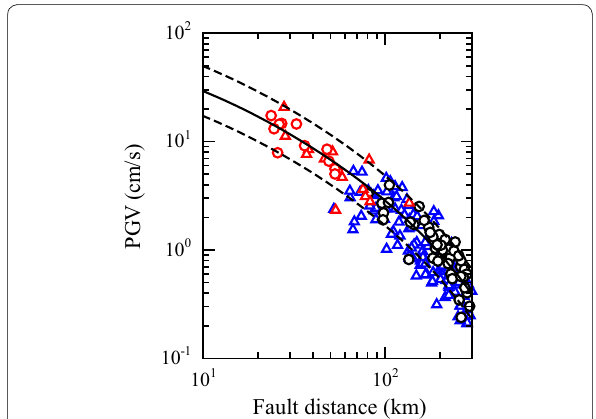
Fig. 17 Observed PGVs after corrections for nonlinear site effects plotted as a function of fault distance. The values were adjusted for nonlinear site effects if rock site PGAs exceeded 50 cm/s 2 , and Vs30 values were lower than about 550 m/s. For further explanation, see the text and figure captions in Fig.